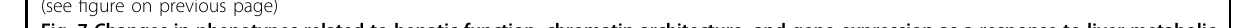
Fig. 7 Changes in phenotypes related to hepatic function, chromatin architecture, and gene expression as a response to liver metabolic stress in pigs. a Comparison of obesity-related phenotypes. b Representative H&E staining of paraf fi n sections and measurement of triglyceride contents in the liver. Data represent means ± SD. c Serum concentrations of fi ve metabolic indicators. TG triglyceride, LDL low-density lipoprotein, HDL high-density lipoprotein. d Subtle alterations in chromatin architecture, re fl ected by VNE, compartmentalization strength, intra-TAD connectivity, and compartment switching. e Transcriptomic comparison between HFD- and normal diet-fed pig livers. Red dots represent the 126 NAFLD-related genes obtained from the KEGG pathway (ko04932). Five typical NAFLD markers are indicated. f Schematic representation of PEIs, 3D structural models, and Hi-C contact maps for ADIPOQ . Left: a schematic representation of PEIs, H3K4me3, and H3K27ac signals, and transcription. Right: 3D structural models and Hi-C contact maps of the corresponding genomic regions. Gene promoters and enhancers are shown as blue and red spheres,